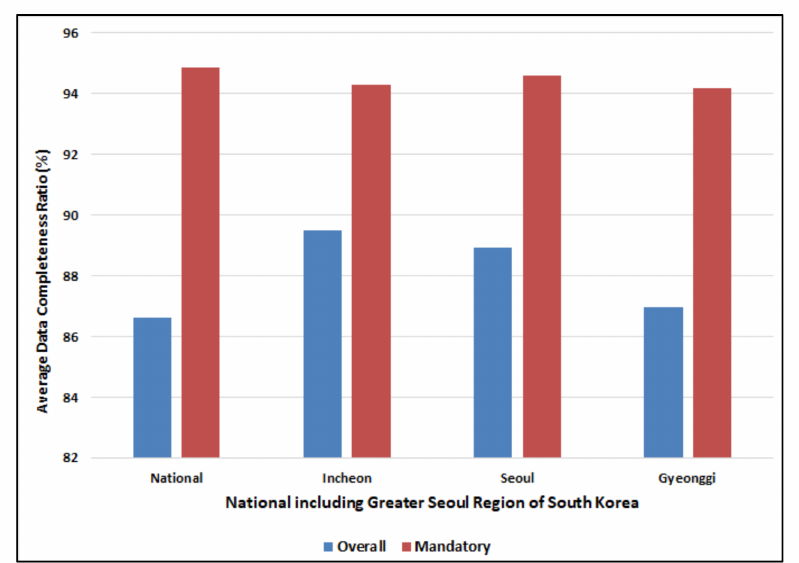
Figure 10. National and Greater Seoul region average DCR considering overall and mandatory data fields.